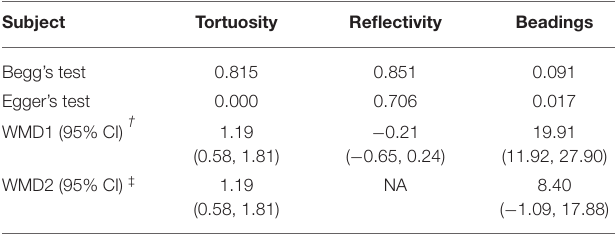
TABLE 4 | Publication bias measured by Begg’s and Egger’s test, WMD (95% CI) recalculated with trim and fill